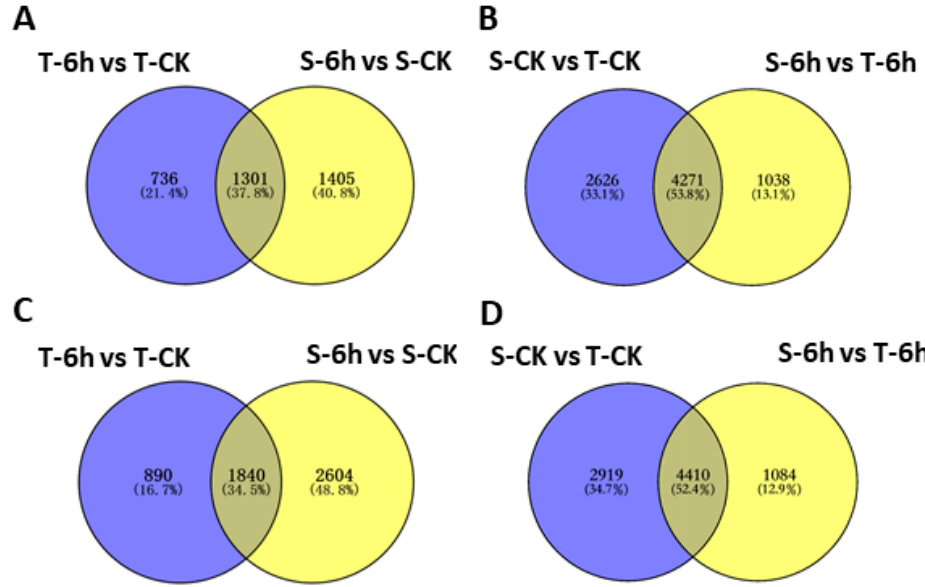
Figure 3. Venn diagrams showing the number of differentially expressed genes (DEGs) between materials and treatments. Down-regulated ( A ) and up-regulated ( C ) genes between materials; down-regulated ( B ) and up-regulated ( D ) genes between treatments. CK, control; T, tolerant; S, sensitive.